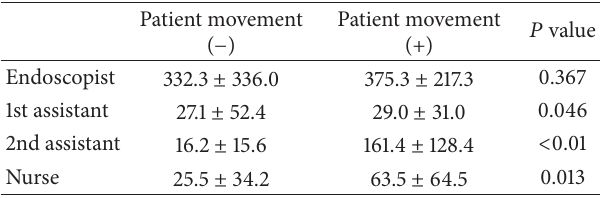
Table 3: Occupational radiation dose to each medical staff member with or without patient movement (without the use of protective curtains) ( 𝜇 Sv).